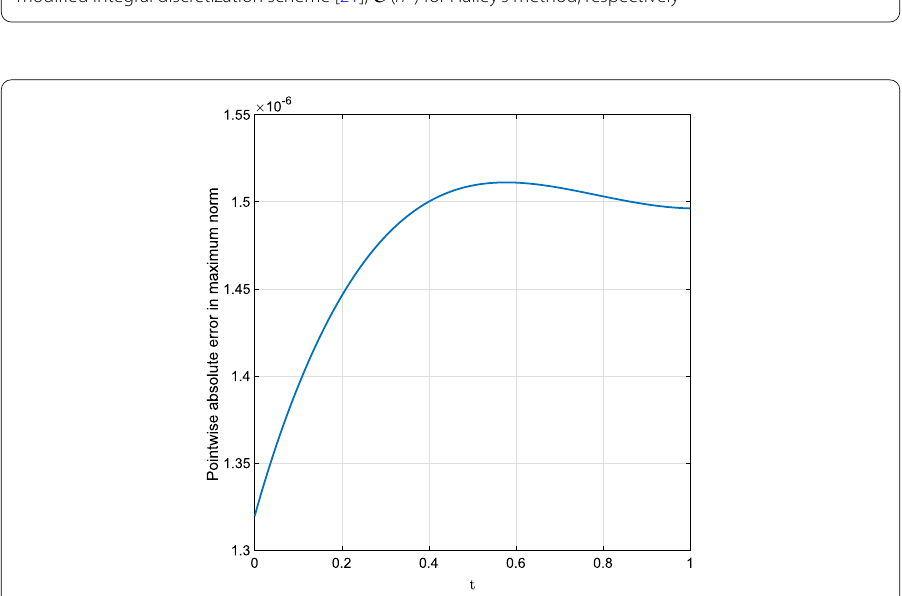
Figure 7 Pointwise absolute errors in maximum norm obtained by the modified integral discretization scheme [21] of Example 4.5 versus the time step h when ( α 1 , α 2 ) = (1 – 10 –16 ,1.7), s 0 = 0.2, N = 320, Tol = 10 –5